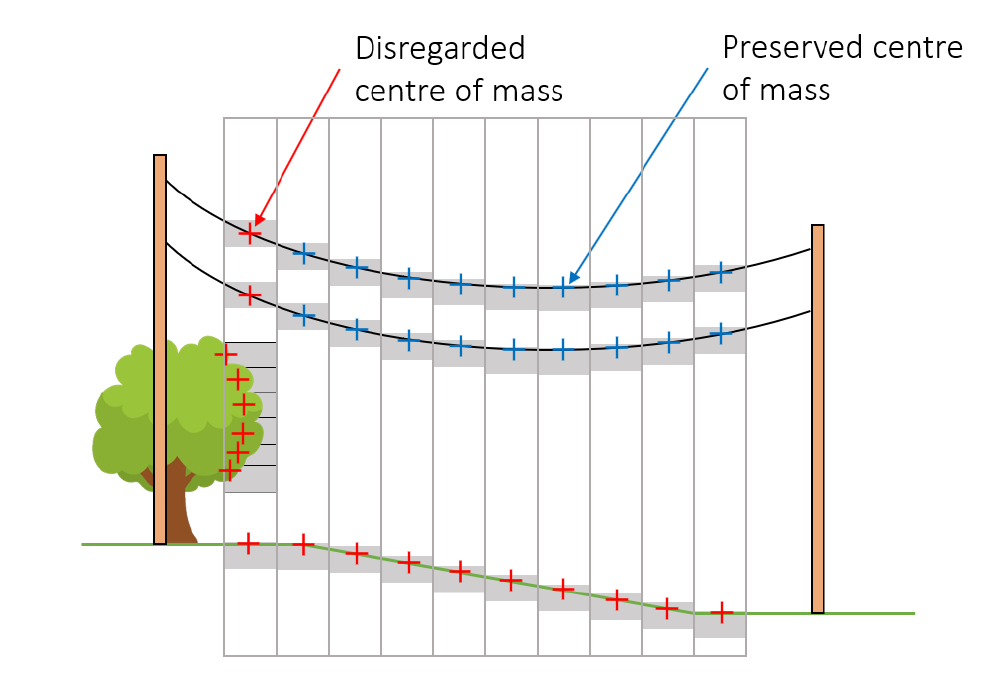
Figure 3. An example of filtered centre of masses. COMs along the ground are filtered due to their low height, those belonging to the tree are filtered due to their close proximity to each other. The left most COMs on the conductors are filtered because they belong to a window with the incorrect number of